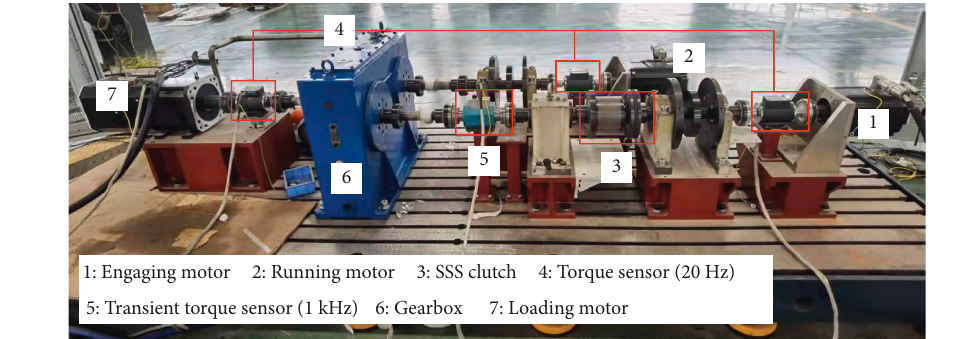
Figure 6: Layout of the experimental equipment.